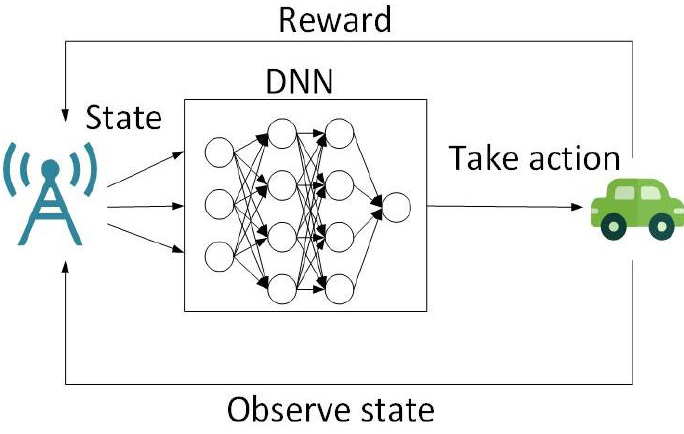
Figure 6. The structure of the DQN algorithm.